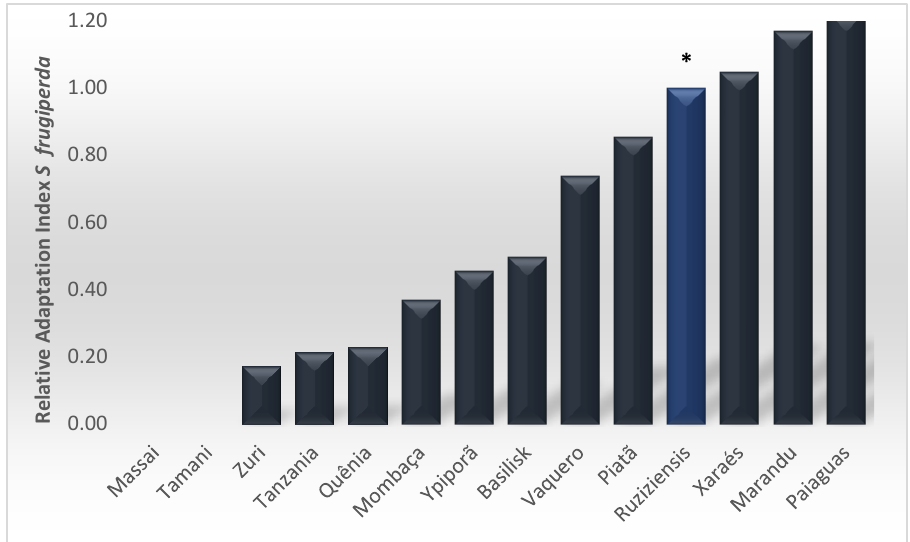
Figure 4. Relative suitability index (RSI) which assesses the larval performance on different alternative hosts, where: SI = larval survival (%) × pupae biomass (mg)/larval development time (days), related to the suitability index (SI) of Brachiaria ruziziensis * .